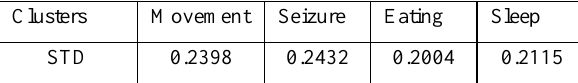
Table 2 . standard deviations of the feature descriptions of events from the centers of the